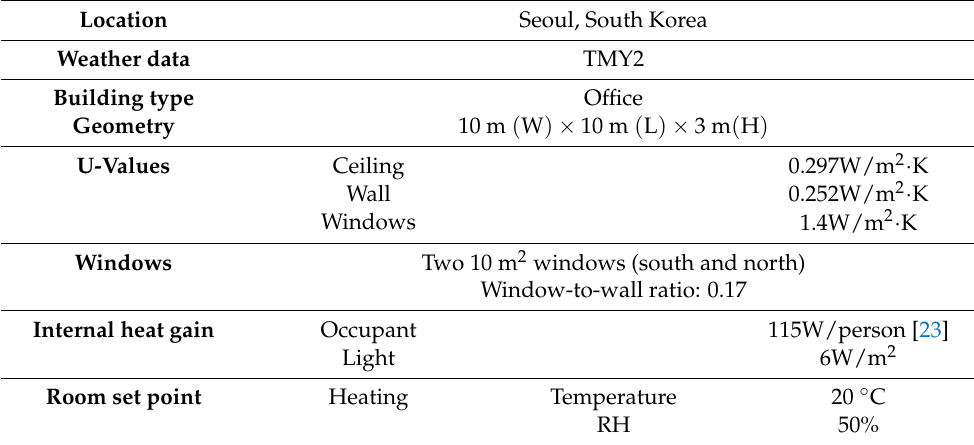
Table 6. Model building